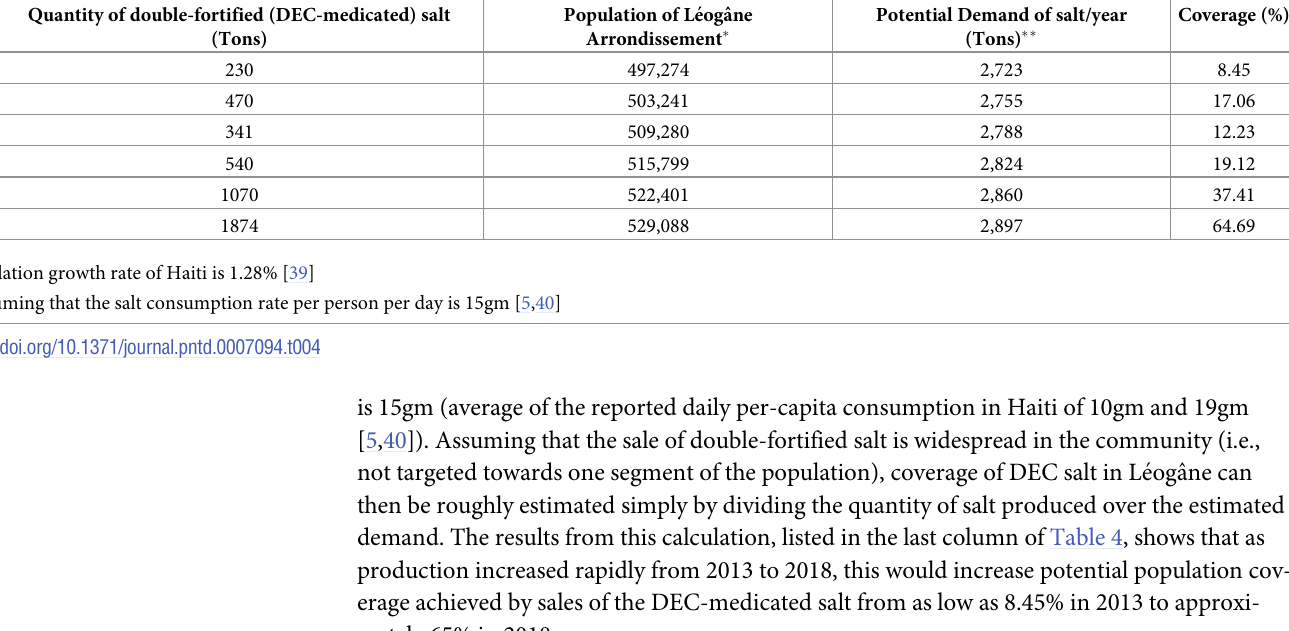
Table 4. Details of production of double-fortified (DEC-medicated) salt (tons), its potential demand/year, and coverage in Le´ogaˆne Arrondissement. Quantity of double-fortified (DEC-medicated) salt